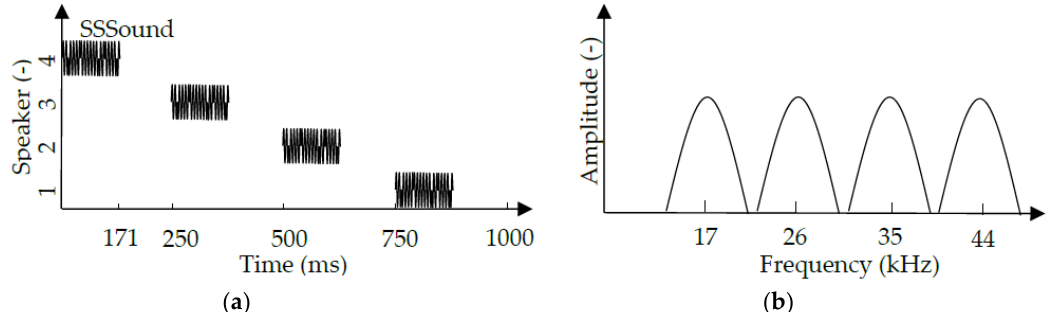
Figure 6. Time-division Multiple Access (TDMA) ( a ) and Frequency-division Multiple Access (FDMA) ( b ) signal.